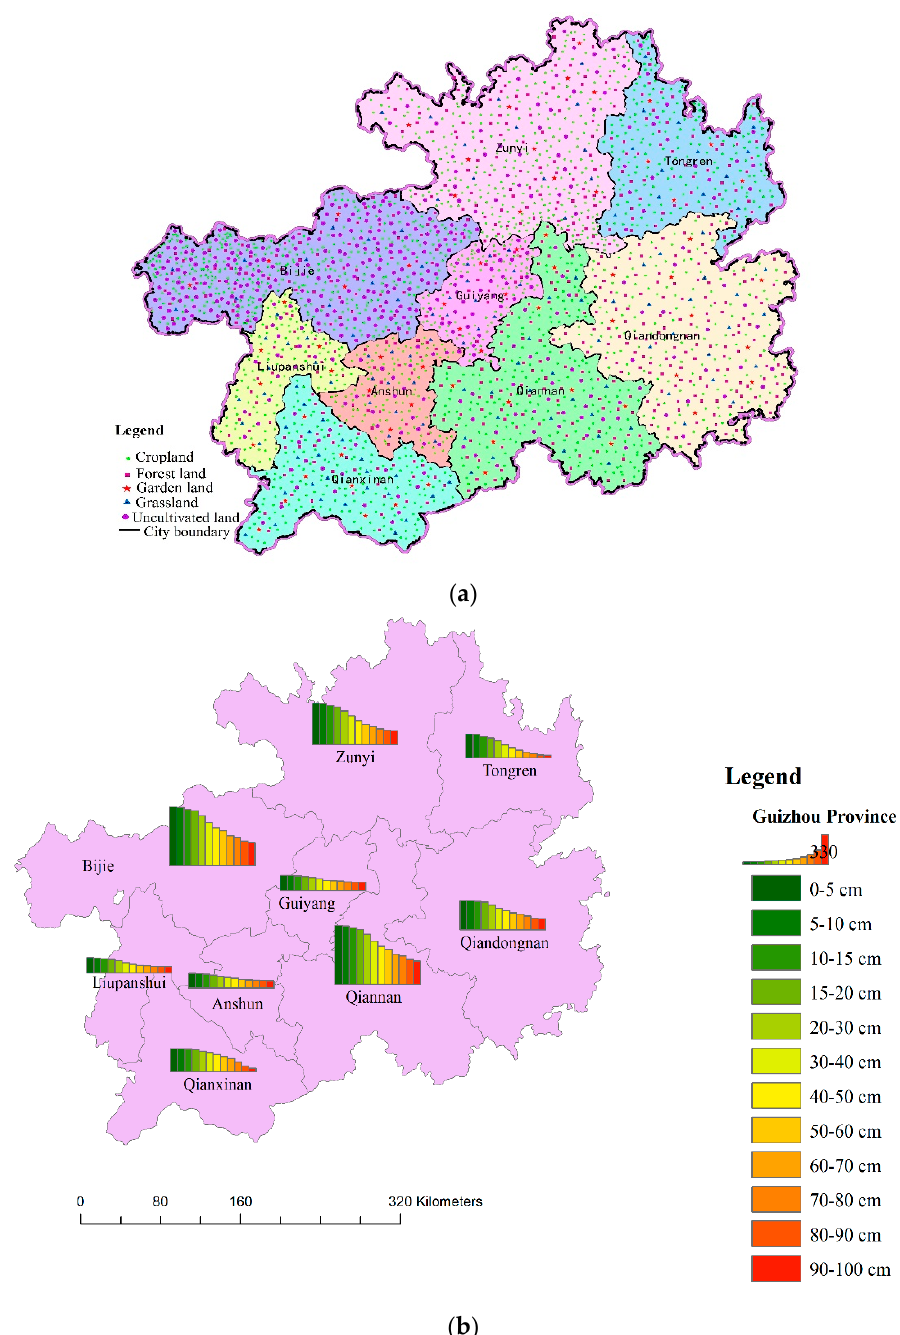
Figure 2. Distribution of sampling points and samples. ( a ) Distribution of sample points in different regions of Guizhou Province; ( b ) Distribution of sample points under different soil thickness.